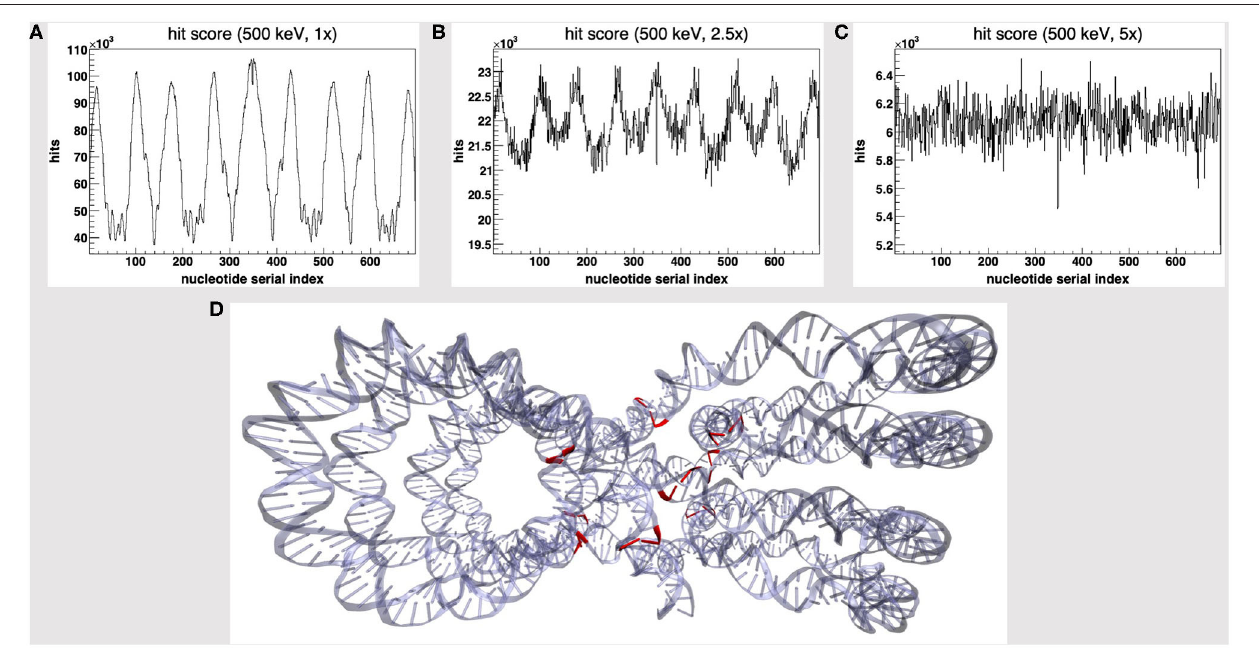
FIGURE 1 | Hit score over the nucleotides serial index, for a set of 500 keV-protons PDB4DNA runs at a (A) 1-fold, (B) 2.5-fold, and (C) 5-fold linear expansion of the reference volume sizes; the spiked behavior shown by the hit counter in (A) vanishes off as the water box is expanded. (D) The nucleotide cluster at the core of the tetranucleosome framework (in red) involves the hit counter spikes in (A)